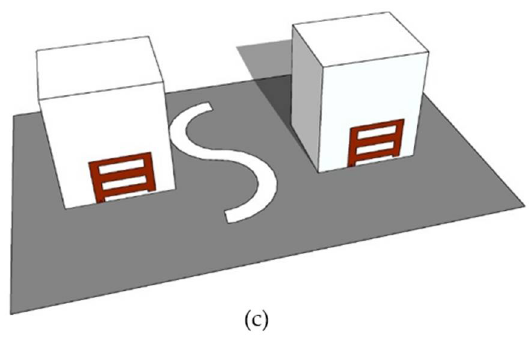
Figure 2. Development of the RDRA MIMO Antenna (3D view): ( a ) Design-1: MIMO RDRA with a single strip; ( b ) Design-2: MIMO RDRA with a novel conformal metal strip; ( c ) desired MIMO RDRA.